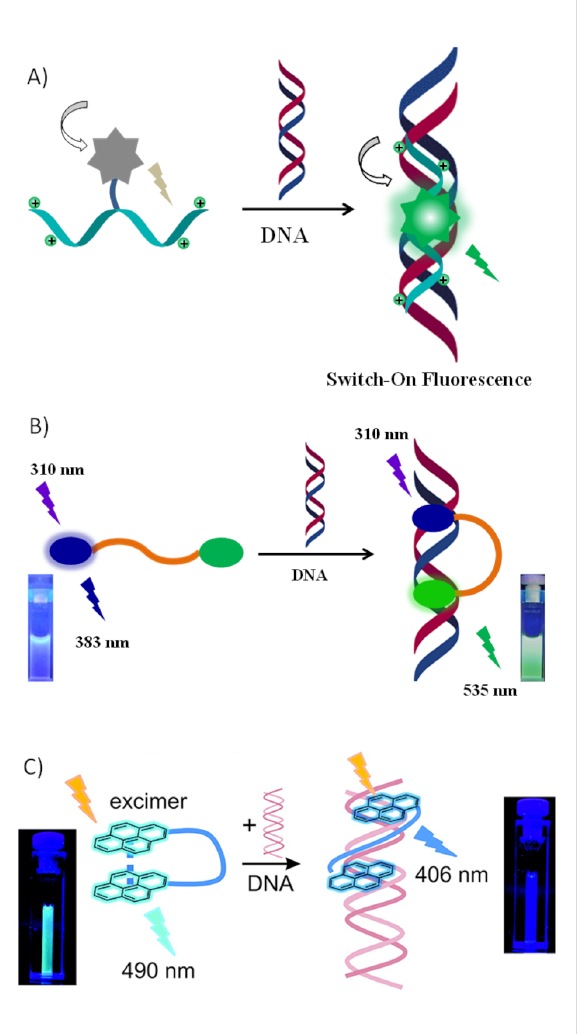
Figure 1: Three different type of peptide-based fluorescent probes and their interaction with nucleic acids are shown. A) Environment-sensi- tive fluorophore attached peptide shows “switch-on” fluorescence response upon interaction with nucleic acids. Reproduced with permis- sion from [32], Maity et al., “Peptide ‐ Based Probes with an Artificial Anion ‐ Binding Motif for Direct Fluorescence “Switch ‐ On” Detection of Nucleic Acid in Cells”, Chem. – Eur. J. © 2017 Wiley ‐ VCH Verlag GmbH & Co. KGaA, Weinheim; B) FRET pair attached peptide shows ratiometric fluorescence response upon interaction with nucleic acids. Reproduced from [33] with permission from The Royal Society of Chemistry; C) a pyrene-attached peptides shows ratiometric fluores- cence response upon interaction with nucleic acids. Reprinted with permission from [34]. Copyright (2012) American Chemical